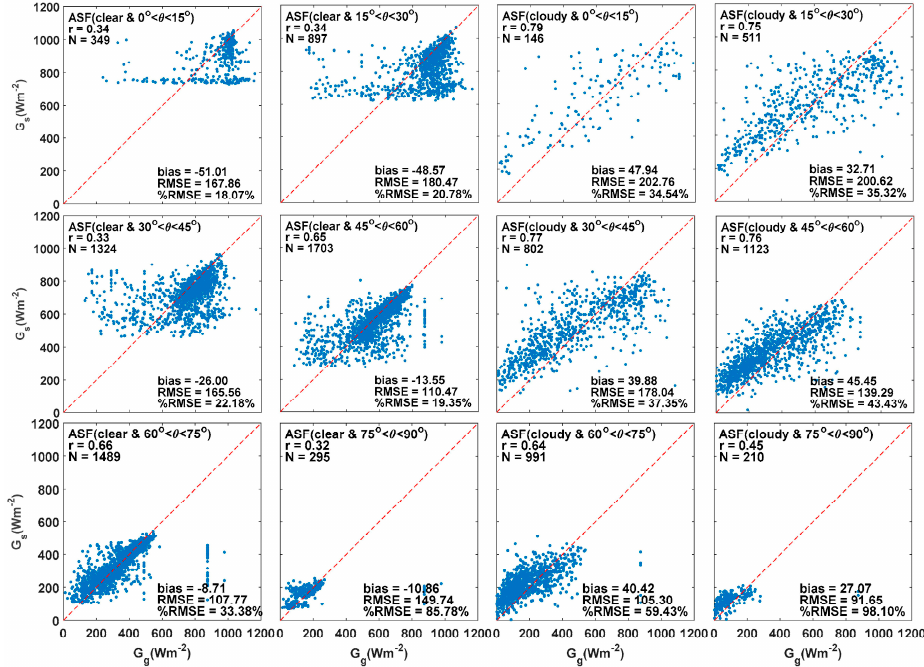
Figure 9. Same as Figure 8 but for the ASF site.